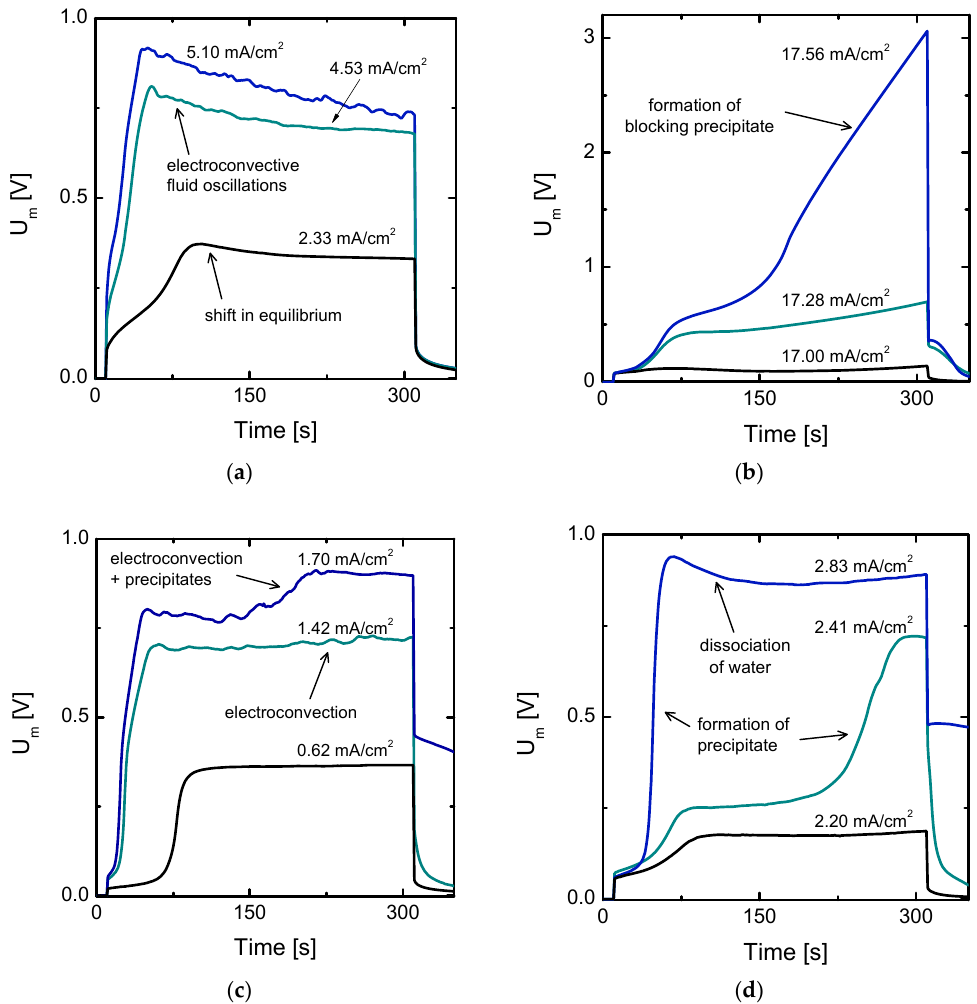
Figure 6. Examples of the evolution of chronopotentiograms at increasing current densities where overlimiting current transfer mechanisms evolve. ( a ) Curves obtained with Cr 2 (SO 4 ) 3 solutions where electroconvective vortices evolve; ( b ) curves obtained with Fe 2 (SO 4 ) 3 solutions where the formation of precipitates blocks the membrane surface and hampers overlimiting currents; ( c ) curves obtained with 5 × 10 − 3 M NiSO 4 solutions where first electroconvection arises and then electroconvective vortices coexist with the formation of precipitates; ( d ) curves obtained with 2 × 10 − 2 M NiSO 4 solutions where precipitates are formed before activation of electroconvection and then the dissociation of water is